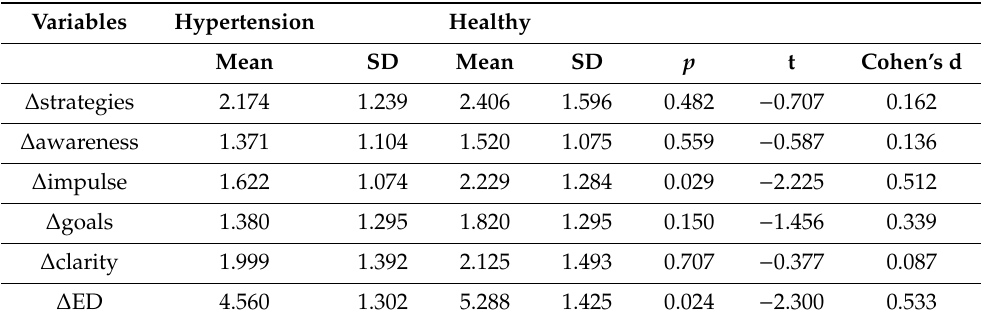
Table 11. Di ff erences between groups: independent sample t -test and Cohen’s d coe ffi cient. Gr.1: hypertensive patients, n = 41, Gr.2: healthy persons, n =